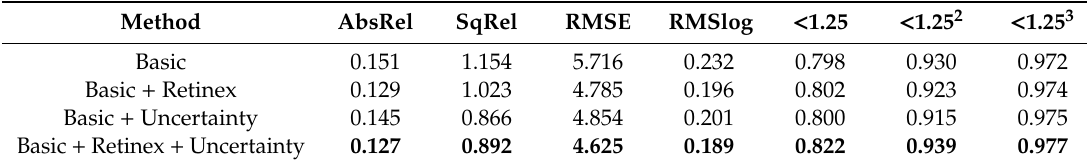
Table 3. Ablation study (Input image resolution: 832 ×